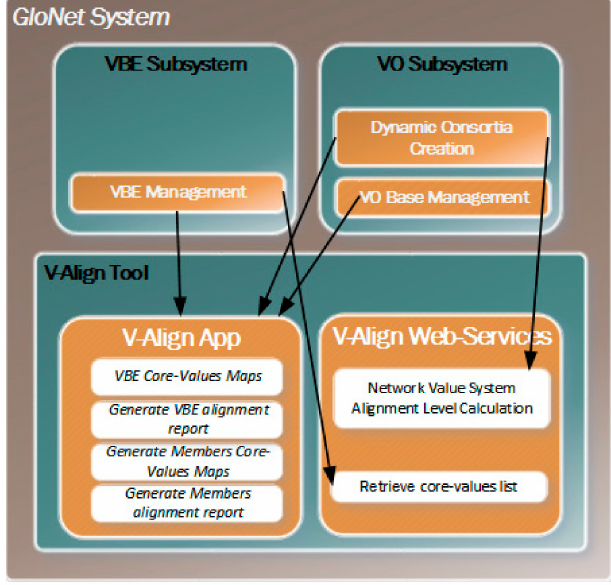
Figure 5. Integration between V-Align Tool and GloNet